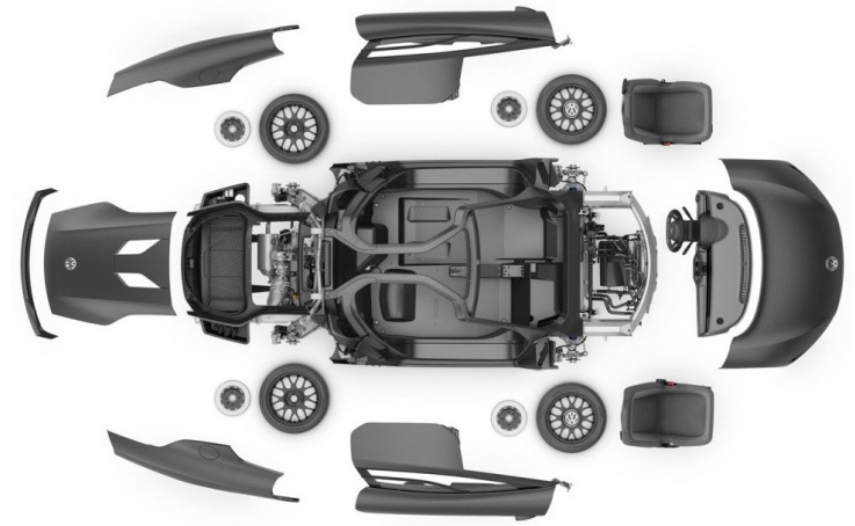
Figure 17. Volkswagen xl1 carbon fiber body parts, reproduced from [218] under open access license.